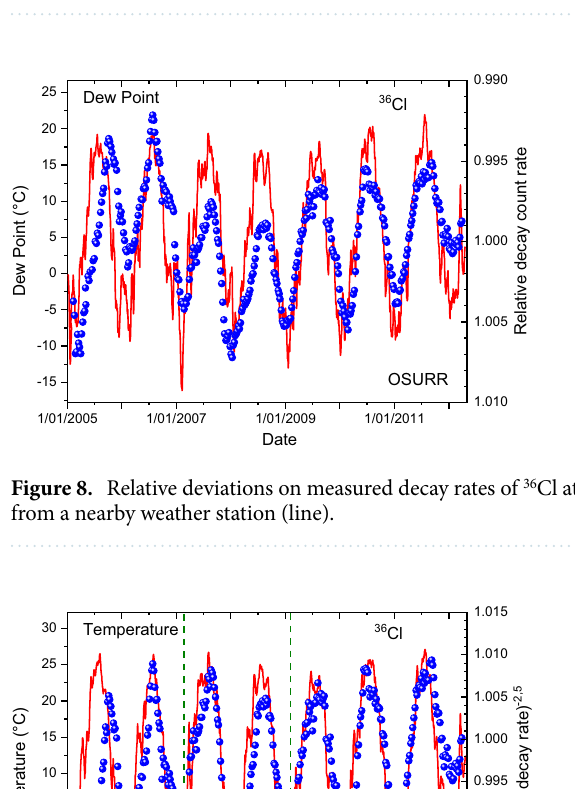
Figure 7. Relative deviations on measured decay rates of 36 Cl at OSURR (dots), compared to temperature data from a nearby weather station (line).